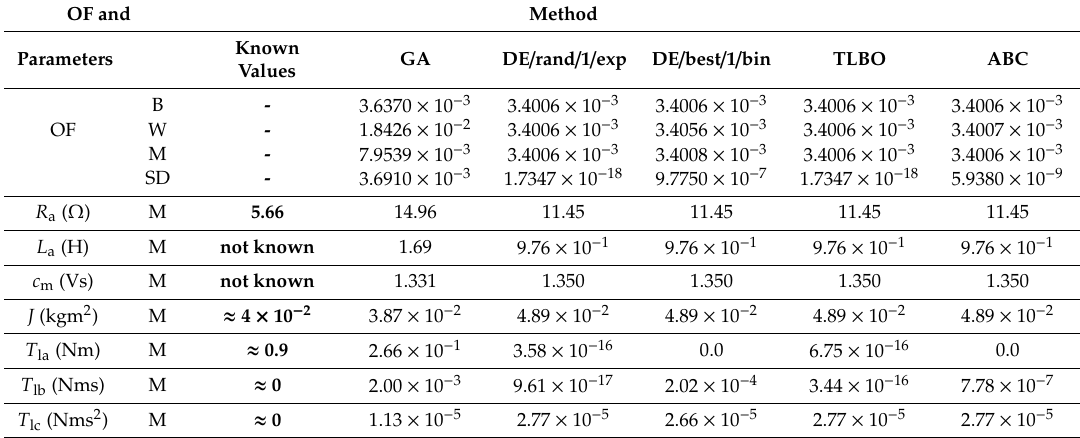
Table 11. OF and Mean value of the calculated parameters for 50 independent runs using EM for MD2.